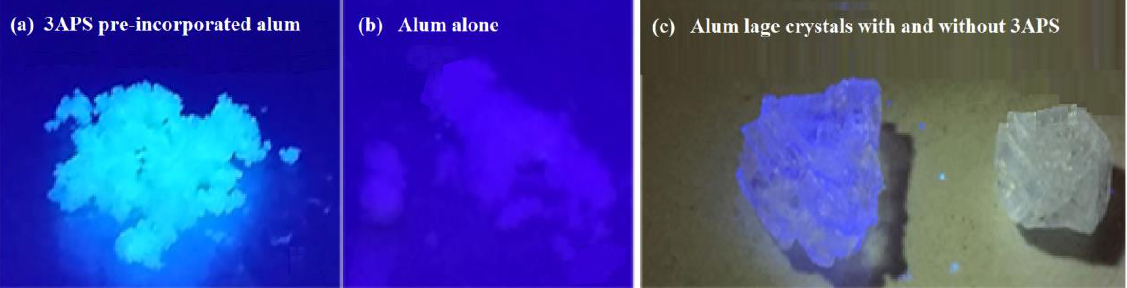
Figure 15 . 3APS preincorporated with alum under UV lamp at 365 nm ( a ); alum by itself under UV